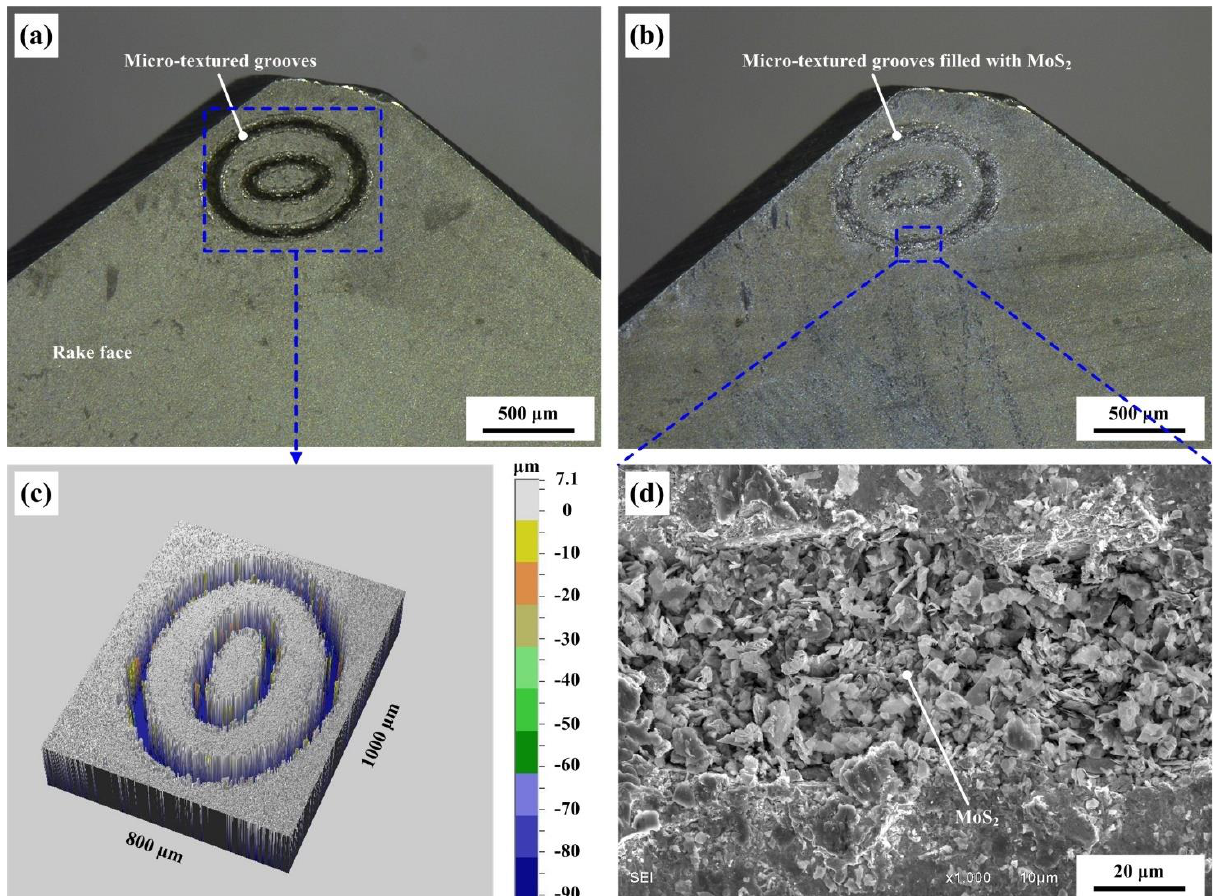
Figure 1. Micrographs of the micro-textured grooves: ( a ) without solid lubricant, ( b ) filled with molybdenum disulfide, ( c ) 3D topography, and ( d ) magnified topography of the grooves filled with molybdenum disulfide.